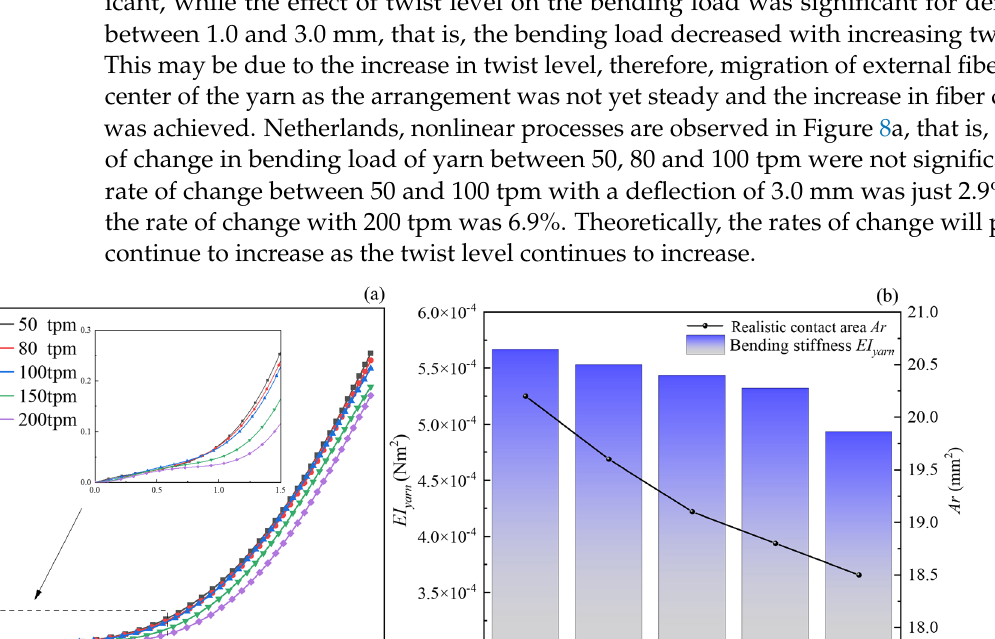
Figure 7. Prediction of the geometric model with different twist levels: ( a ) 50 tpm; ( b ) 80 tpm; ( c ) 100 tpm; ( d ) 150 tpm; and ( e ) 200 tpm.